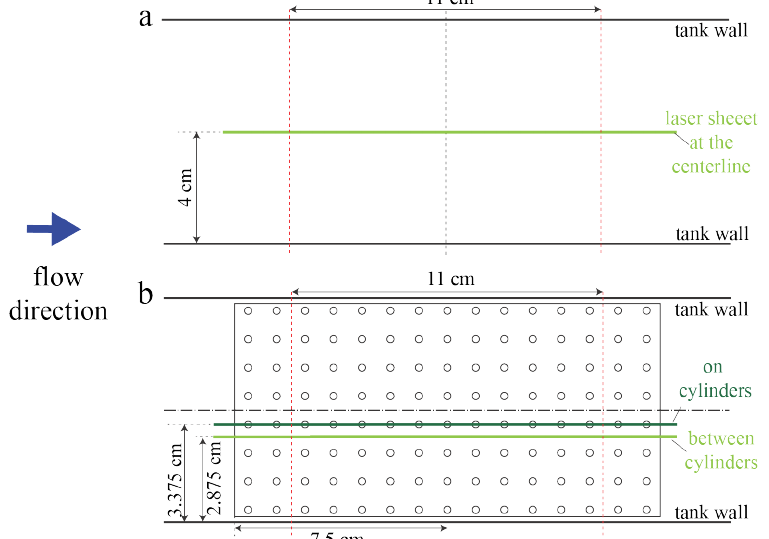
Figure 2. Position of laser sheet for the empty tank ( a ) and the cylinder models ( b ). Light and dark green lines denote the position of the laser at different times. The vertical dashed-dotted line is the y-axis. Dashed-dotted horizontal lines represent the x-axis for each setup. Red dashed-lines denote the beginning and the end the region that the camera can capture for PIV. The dark blue arrow shows the direction of flow during PIV